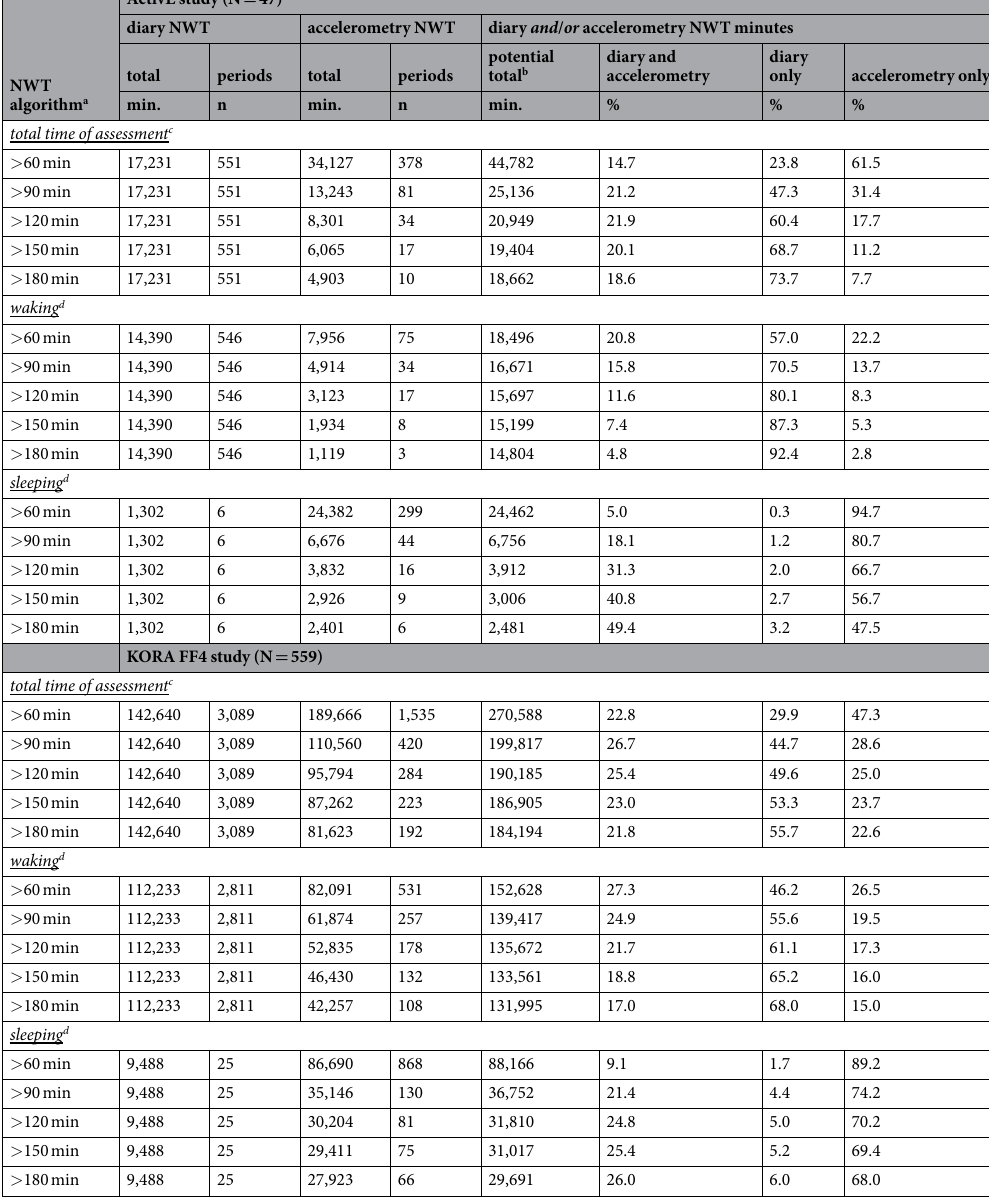
Table 4. Overlap of any diary NWT with accelerometry NWT identified using the > 60-min to > 180-min algorithms. NWT, non-wear time. a Algorithms were applied only to accelerometry data to check for periods based on consecutive acceleration zero-counts > 60, > 90, > 120, > 150, and > 180 minutes, respectively. b Potential total NWT includes NWT which is NWT detected by either diary , accelerometry , or both . c Analyses were conducted from the first to the last recorded time point of assessment in the diary. d Waking and sleeping phases were derived from participants’ diary